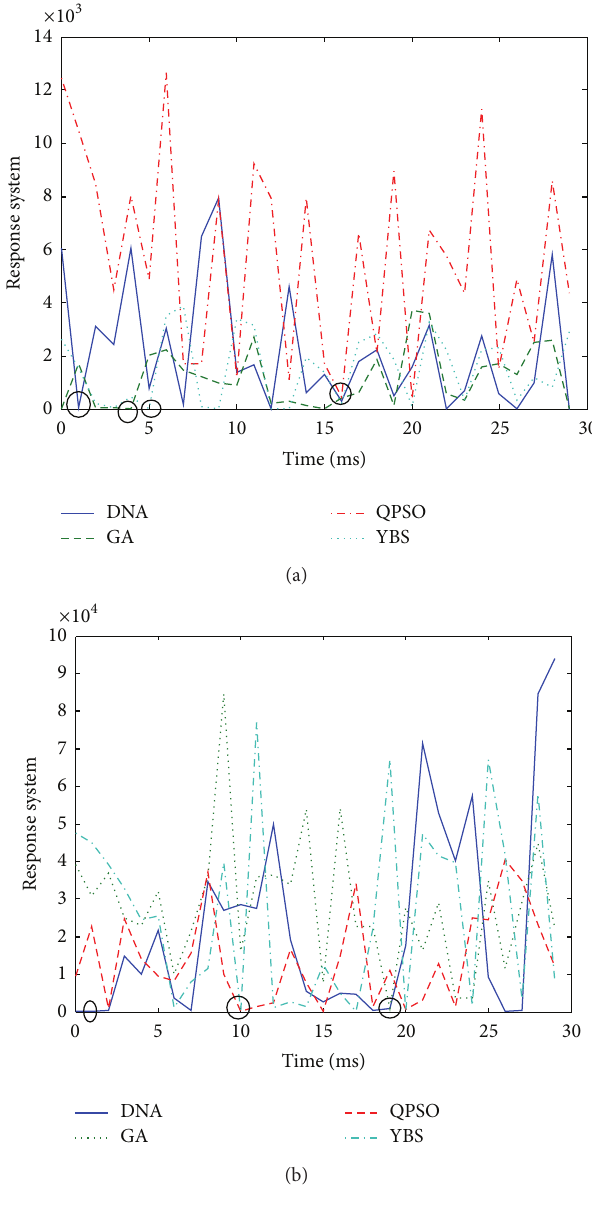
Figure 6: Comparison